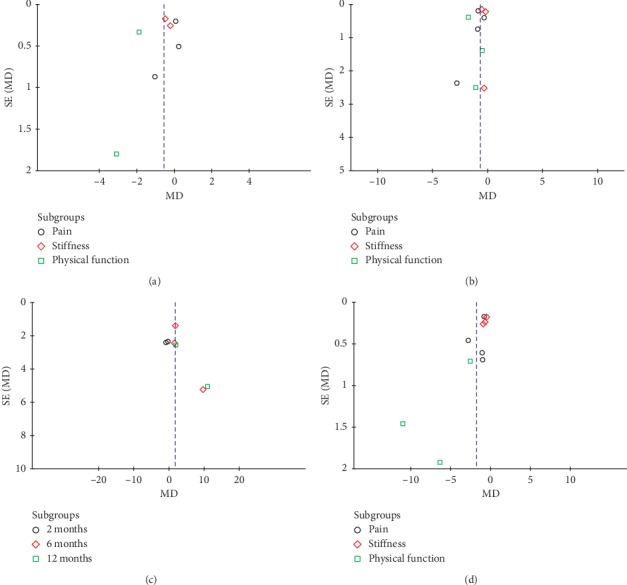
Funnel plot to detect publication bias. (a) WOMAC scores at 3rd months. (b) WOMAC scores at 6th months. (c) IKDC score. (d) WOMAC scores at 12th months.